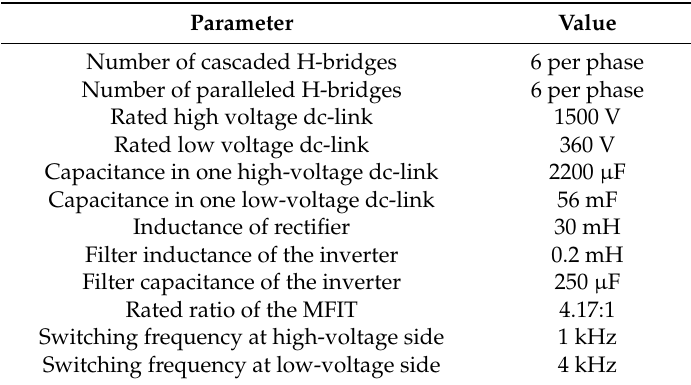
Table 1. Main parameters of the 10 kV/400 V 1MVA